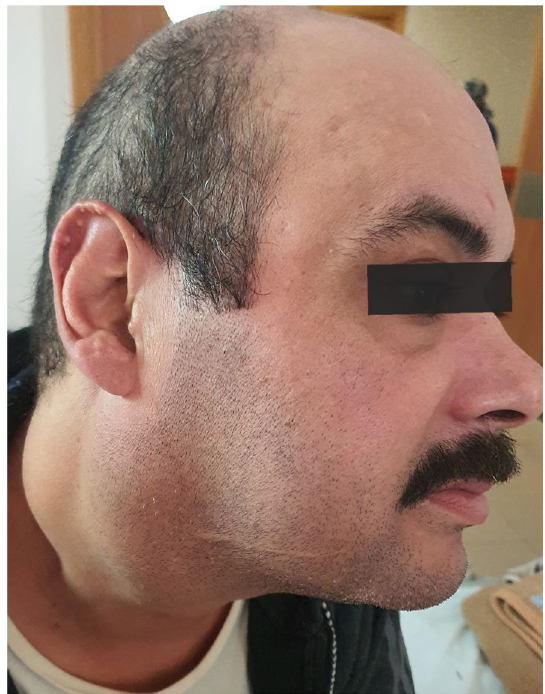
Fig. 1 Clinical appearance of the mass preoperatively